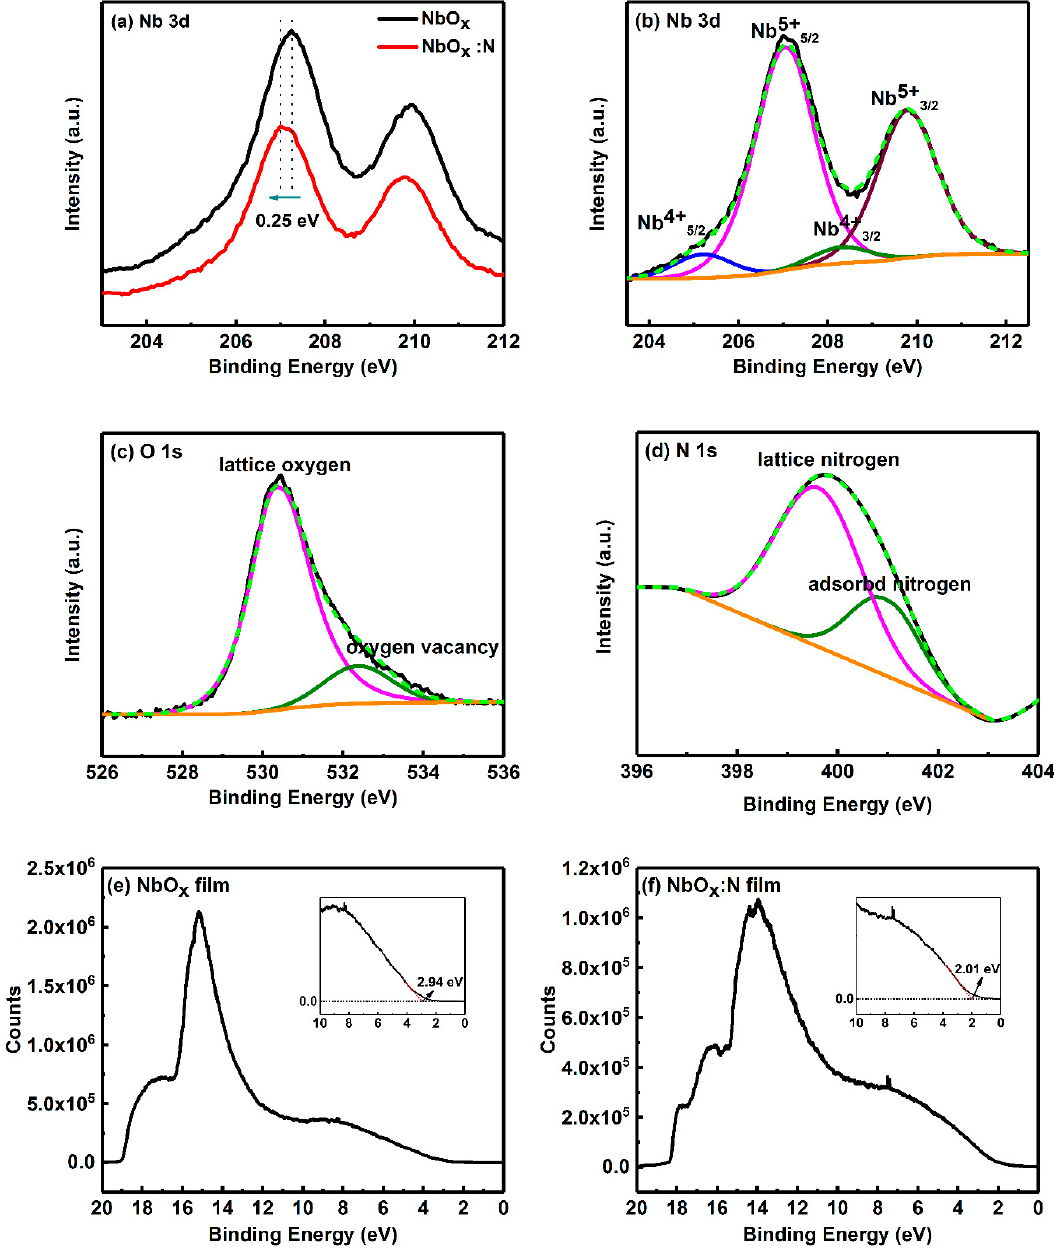
Figure 3. ( a ) Comparison of Nb 3d core level spectra in NbO x and NbO x :N films. ( b ) Nb 3d, ( c ) O 1s, and ( d ) N 1s core-level fitting spectra of NbO x :N film. UPS spectra of ( e ) NbO x and ( f ) NbO x :N film, measured with − 6 V bias. The red dotted line represents the Fermi edge of each sample in subfigures ( e , f